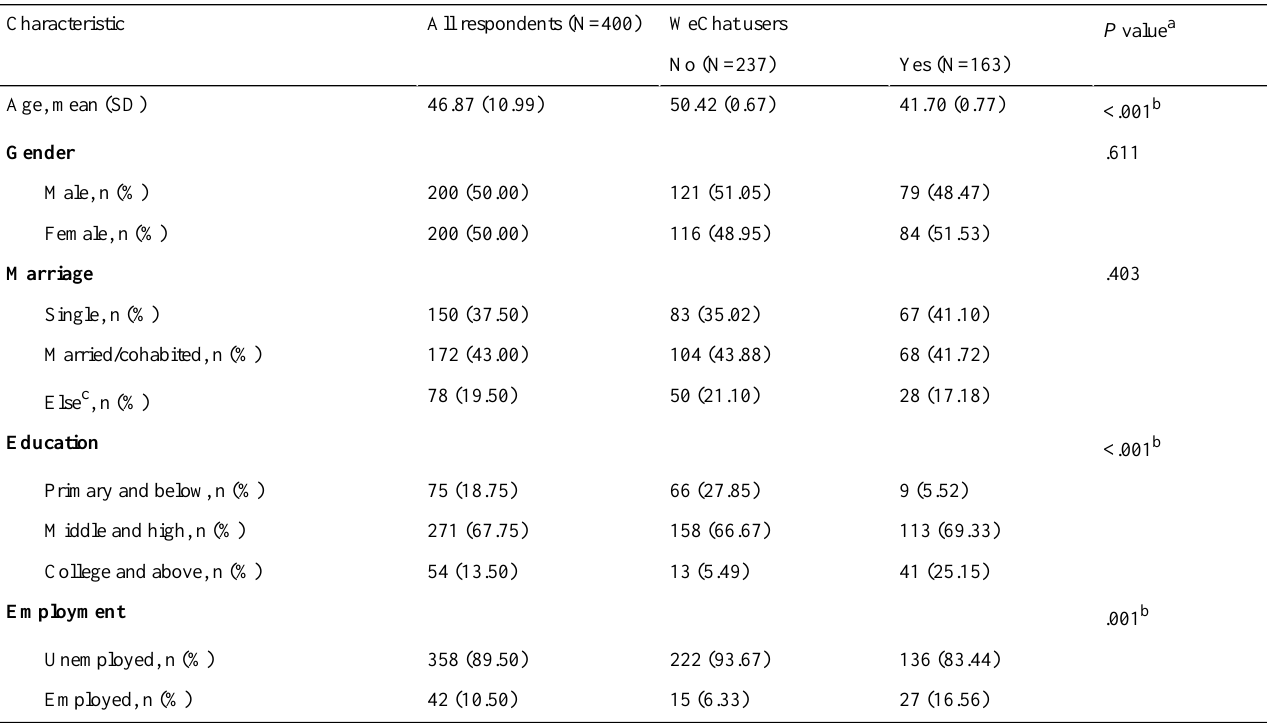
Table 3. Sociodemographic comparison between WeChat users and nonusers.